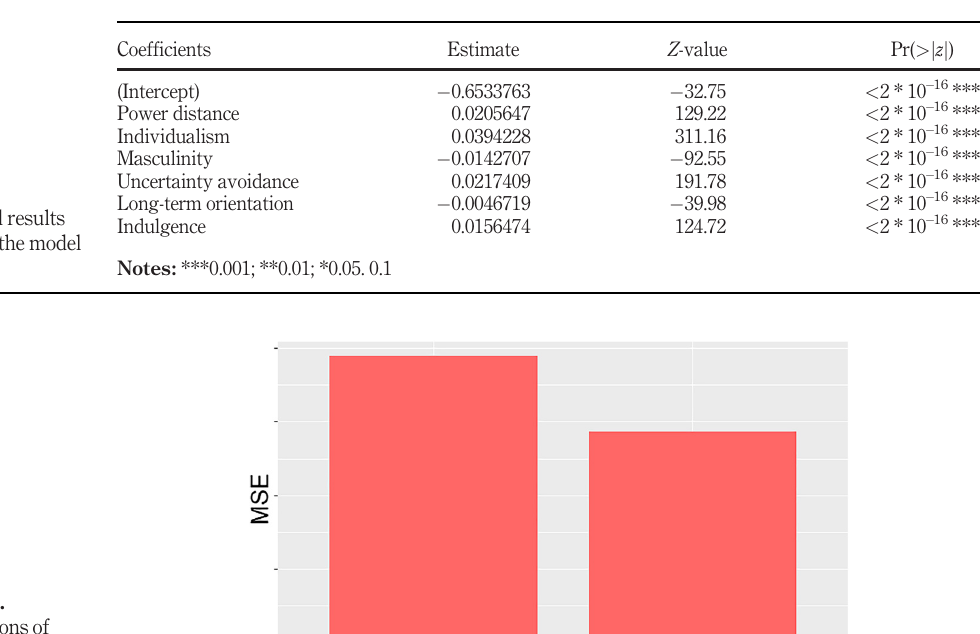
Figure 4. Comparisons of models